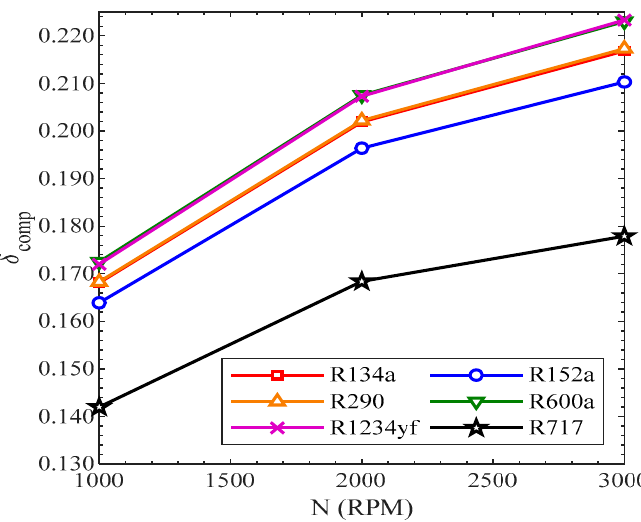
Figure 18 . Efficiency defect of compressor vs. compressor speed .